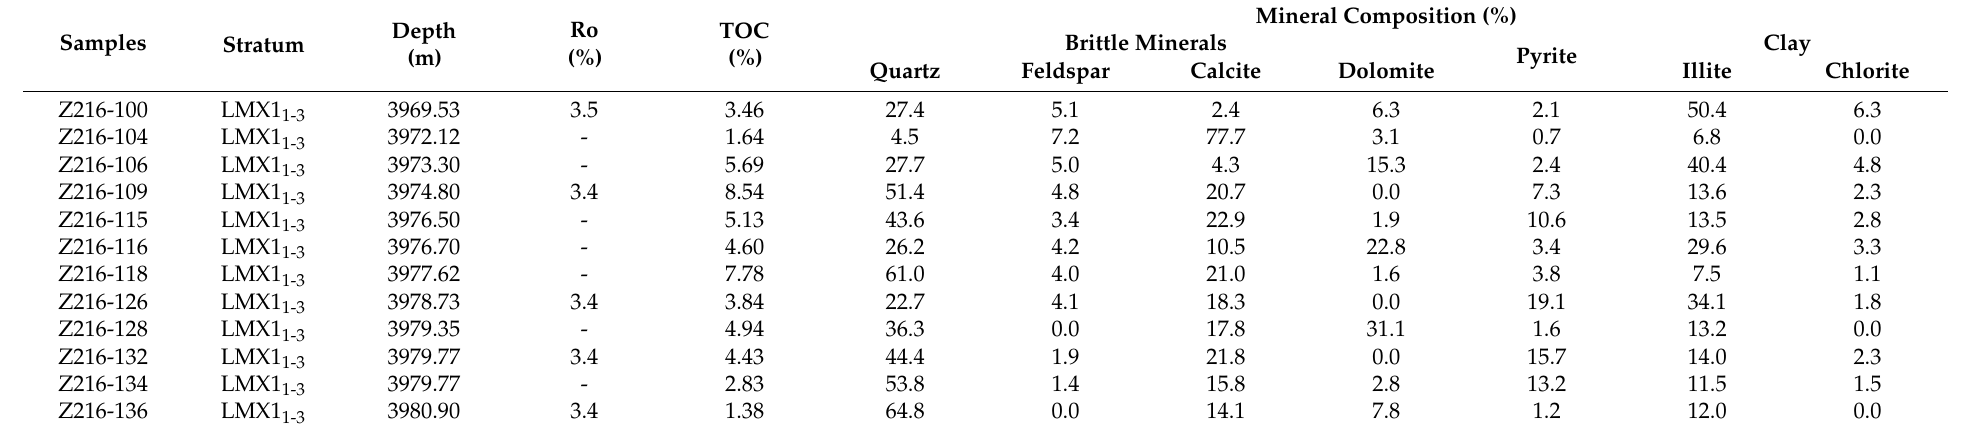
Table 1. Geological and geochemical characteristics as well as the mineral compositions of the deep shale samples from the Luzhou